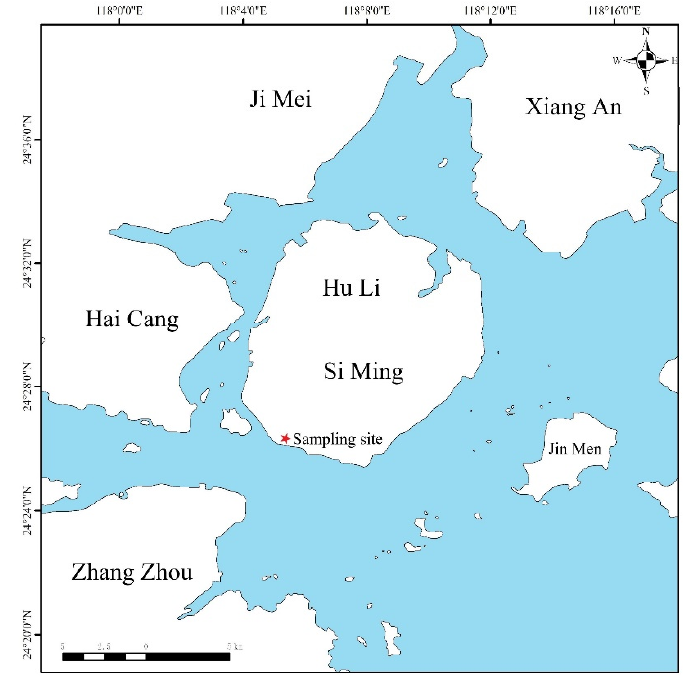
Figure 1. Map of the sampling